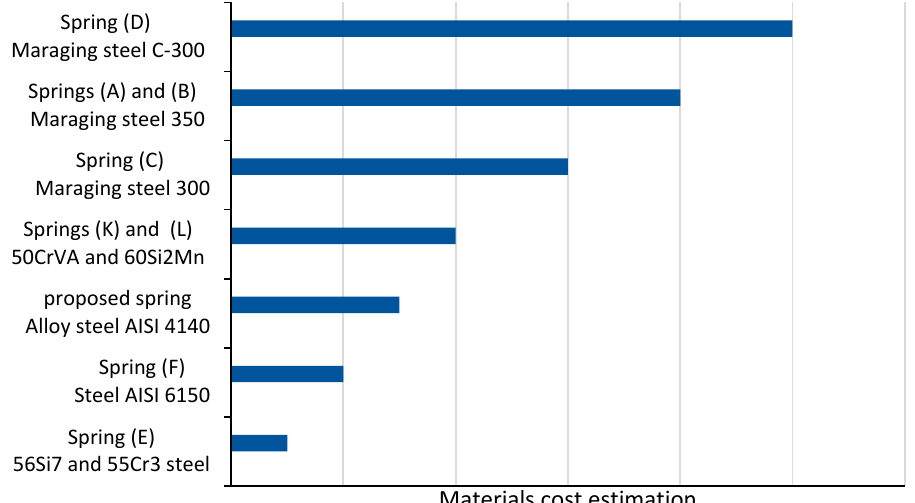
Figure 15. Materials cost estimation for torsion springs. (A) [15]. (B) [10]. (C) [16]. (D) [7]. (E) [17]. (F) [18]. (K) [25]. (L) [22].